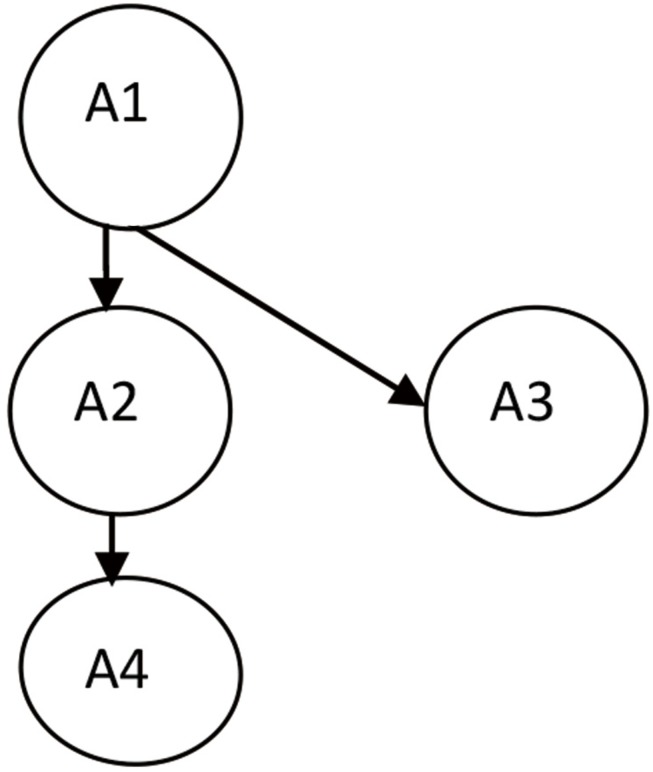
An example of the hierarchical relation between four cognitive attributes.